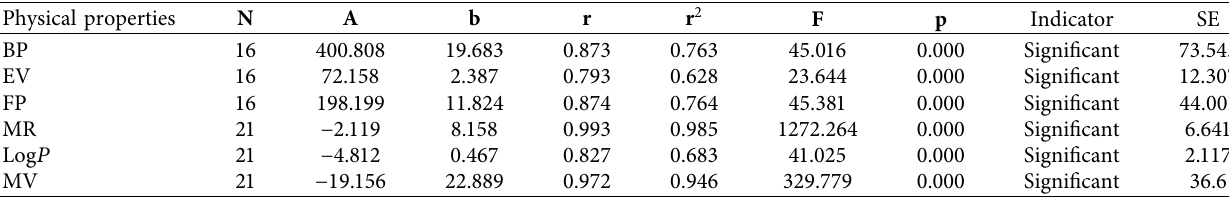
Table 7: Statistical specifications for the linear model of H ( G )